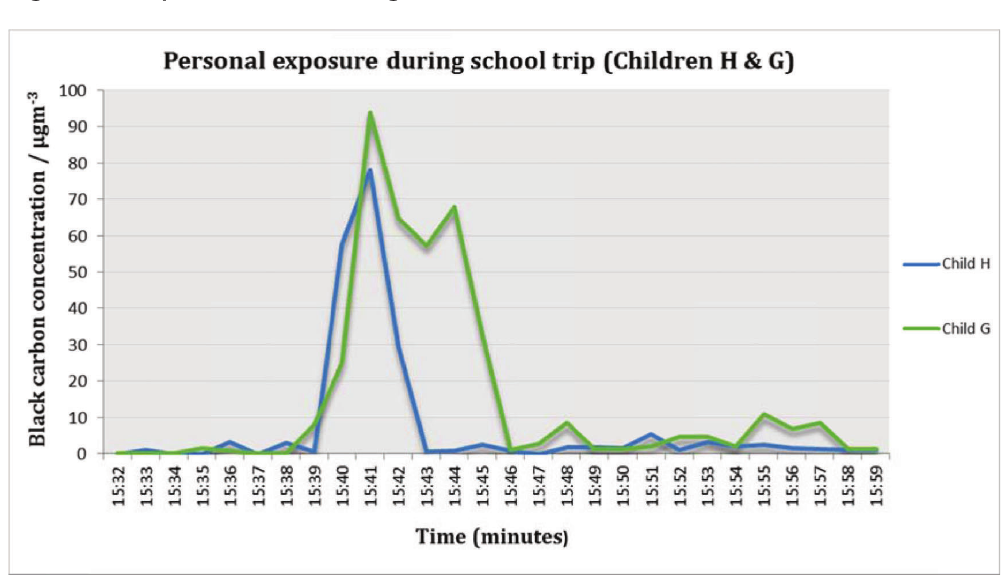
Figure 4: Air pollution monitoring results, Child H and Child G